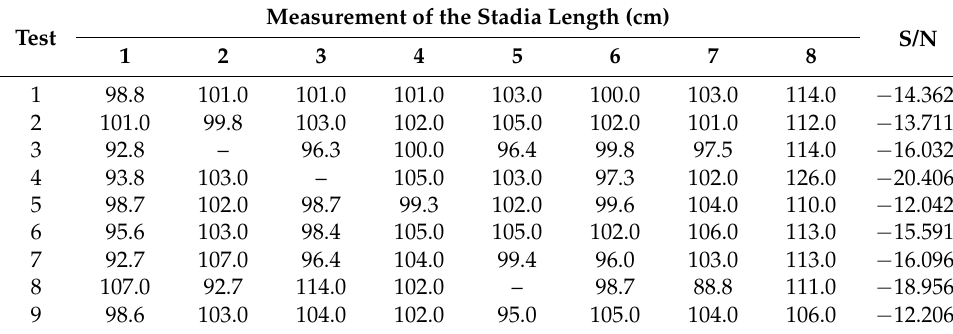
Table 7. Results of the measurement of distances and signal-to-noise ratio.